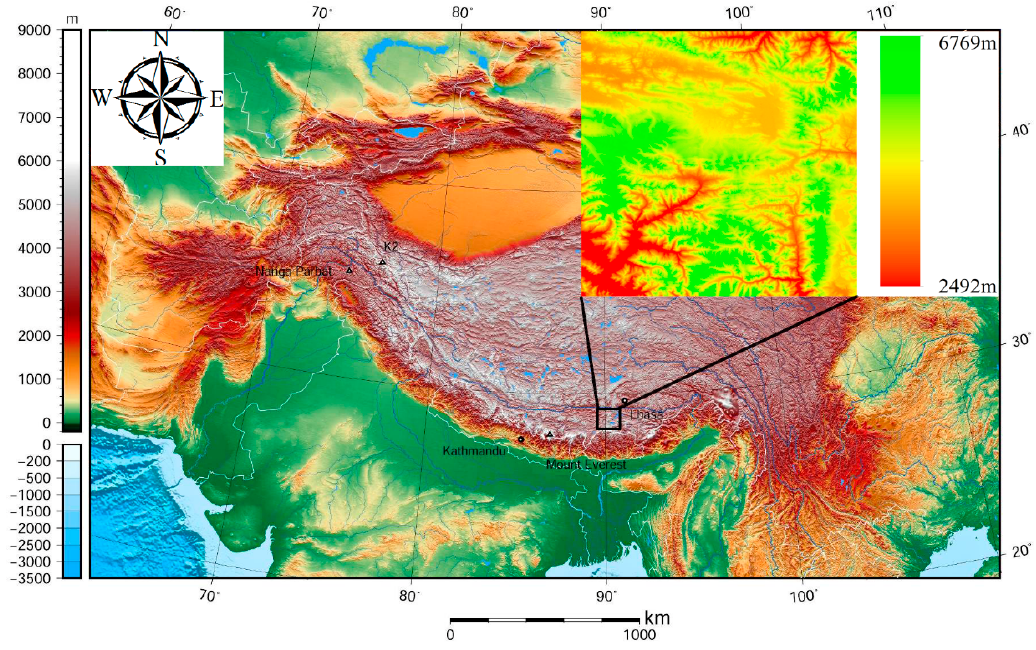
Figure 2. The Tibetan Plateau and the study area.